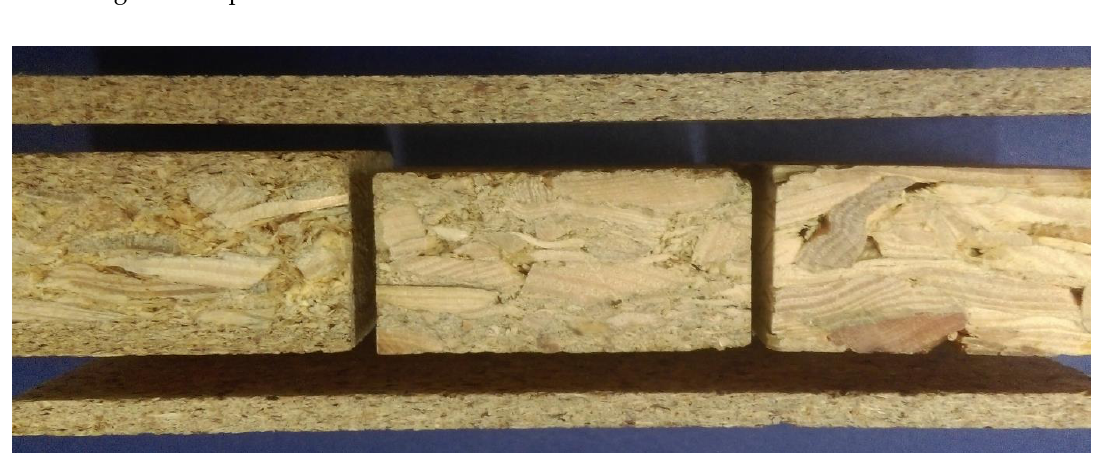
Table 1. Weight and dimensions of the experimental chip.